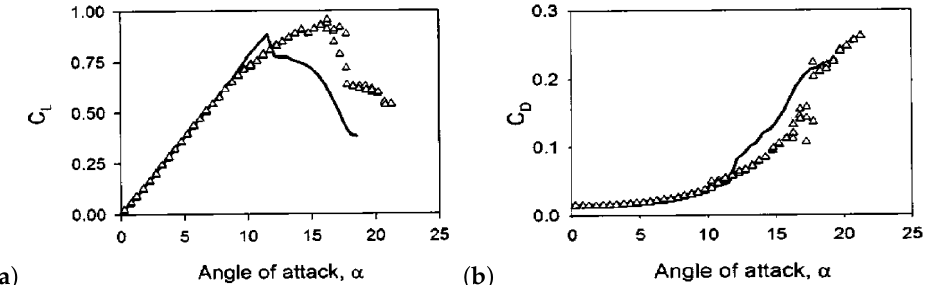
Figure 8. Lift and drag coefficients for the baseline (solid lines) and serrated (triangles) whale flipper model, reprinted from [60] with permission from AIP Publishing: ( a ) lift coefficient; and ( b ) drag